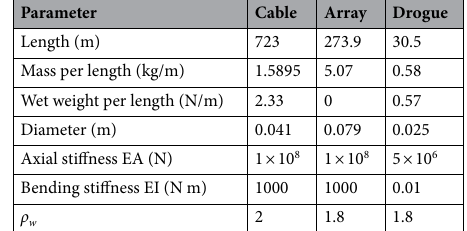
Table 1. Validation